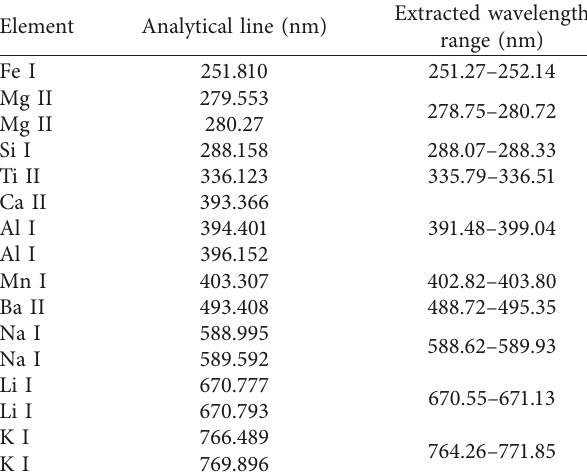
Table 2: Emission lines for classification based on major elements from geological samples.